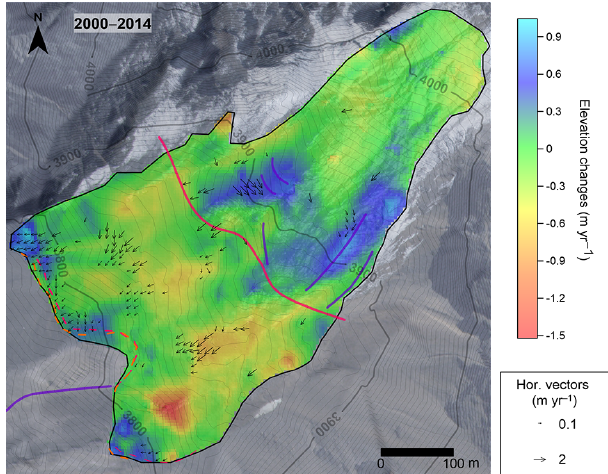
Figure 12. Horizontal displacements and elevation changes at the surface of Presenteseracae between 2000 and 2014. The position of the base of the front at the two dates is indicated with dashed lines, as in Fig. 7; the boundary between rock glacier and debris-covered glacier features and push moraine ridges in the upper part are indi- cated. The background of the map is the 2014 Geoeye image.